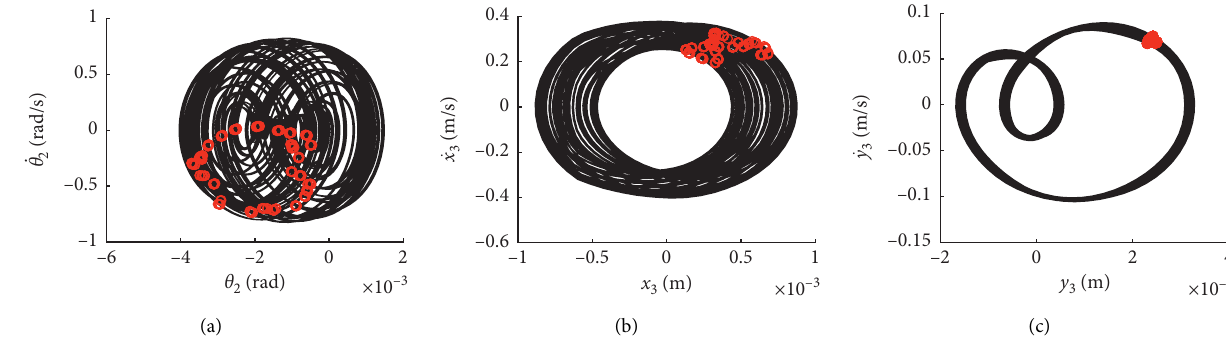
Figure 8: Bifurcation diagram under 0.6 mm structure gap: (a) torsional direction; (b) vertical direction; (c) horizontal